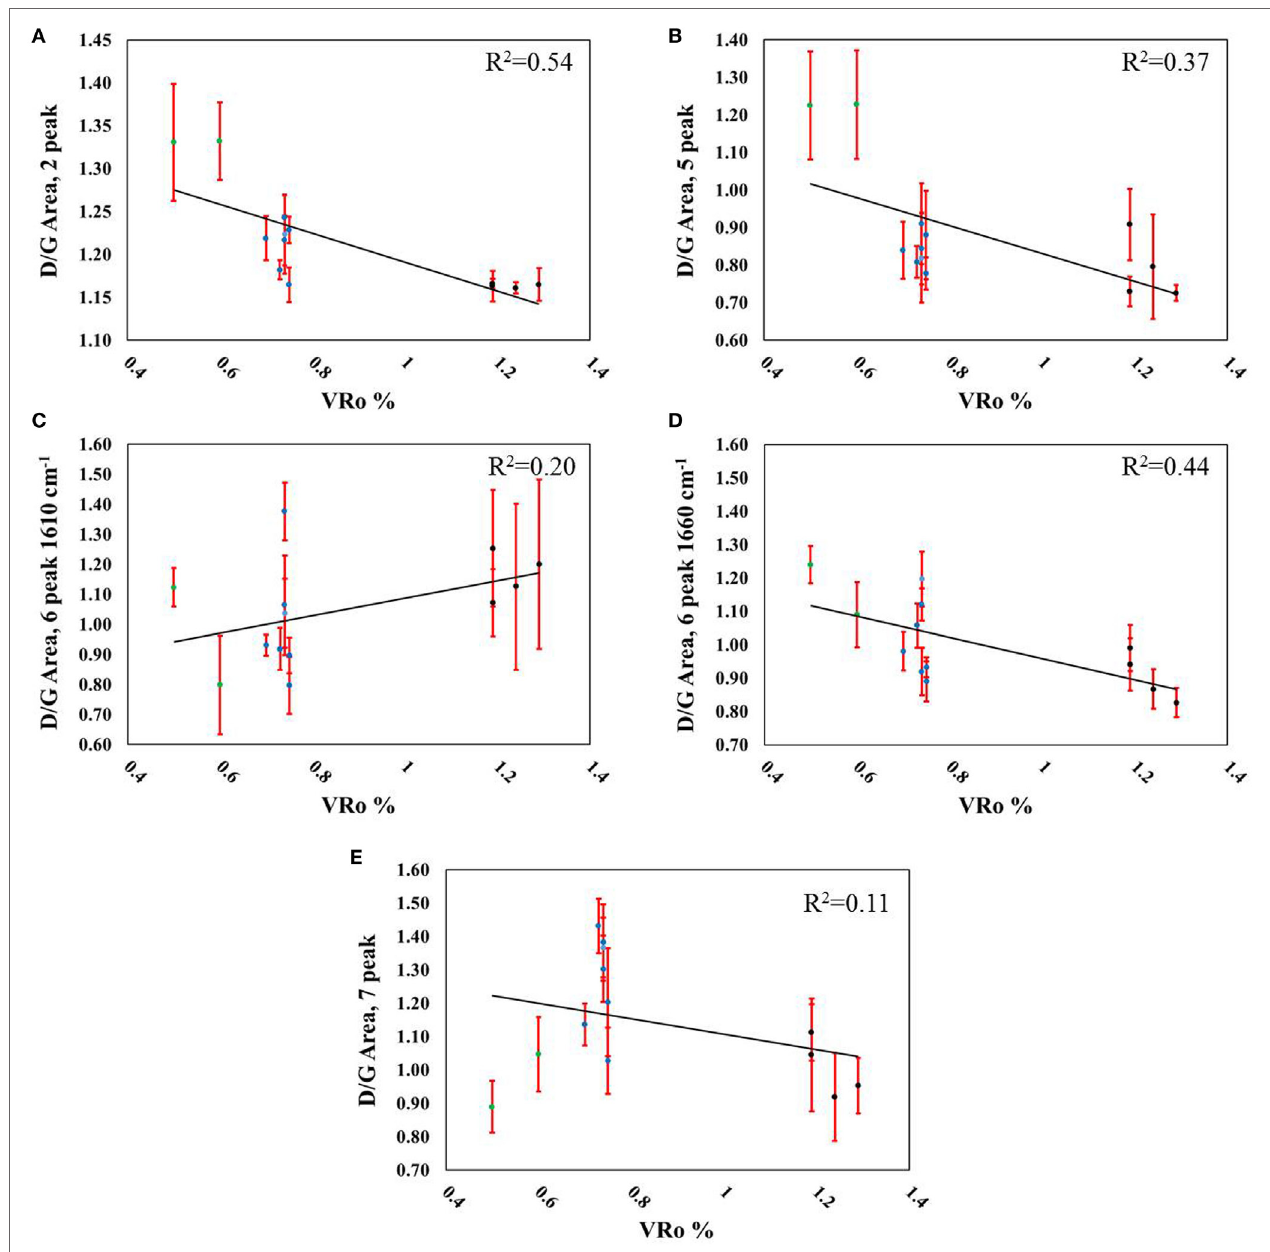
FigUre 9 | Correlations between D/G peak area and measured VRo% using (a) two peaks ( R 2 = 0.54), (b) five peaks ( R 2 = 0.37), (c) six peaks including the D2-band ( R 2 = 0.20), (D) six peaks including a ~1,660 cm − 1 peak ( R 2 = 0.44), and (e) seven peaks ( R 2 = 0.11). Data point legend: green = Aristech wells, blue = Interstate/Columbia wells, black = EQT